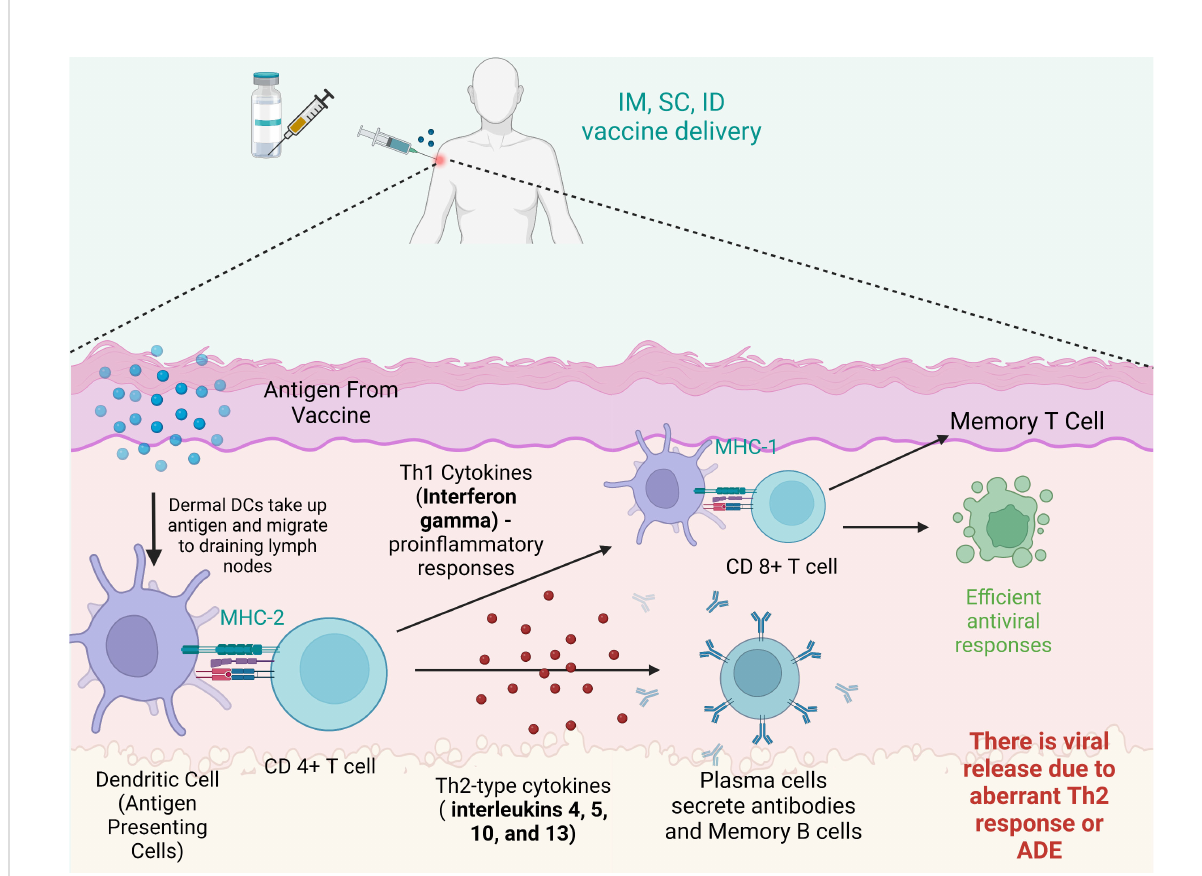
FIGURE 5 Immune reaction after vaccination. After intramuscular (IM), intradermal (ID) or subcutaneous (SC) vaccine delivery, dermal dendritic cells (DCs) take up antigens and migrate to draining lymph nodes to stimulate T cells (CD8+ T cells and CD4+ T cells). Plasma cells secrete antibodies and memory B cells. CD8+ T cells can be stimulated by Th1 cytokines and in turn acquire the ability to attack the infected cells. However, imbalanced immune responses have the potential to cause pulmonary immunopathology, partially due to an aberrant Th2 response or antibody-dependent enhancement (ADE). Created with